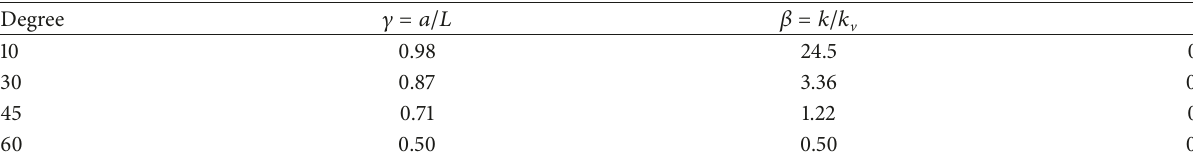
Table 1: Parameters for different angles.